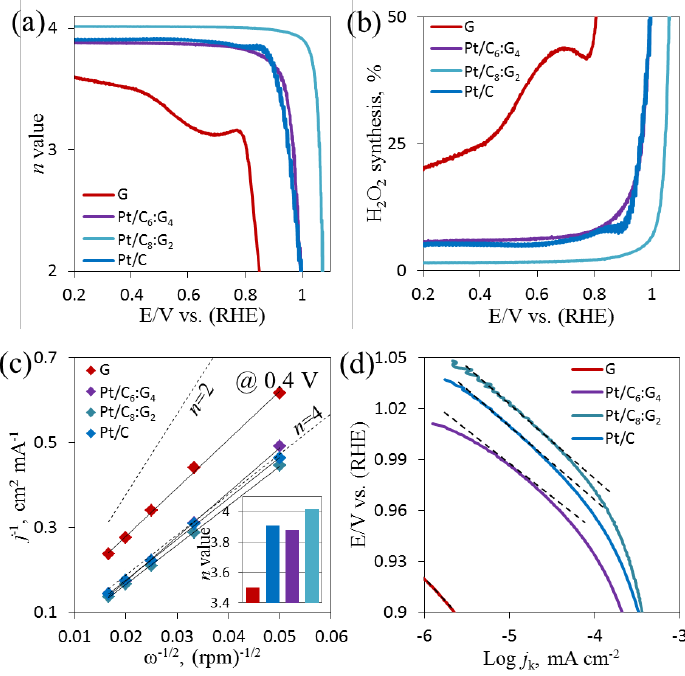
Figure 5. The calculated transferred electron number ( a ), the corresponding H 2 O 2 synthesis ( b ) during ORR in O 2 -saturated 0.1 M HClO 4 solution, the K-L plot comparison at 0.4 V (versus RHE) ( c ) and the Tafel plots ( d ) for Pt / C, Pt / C 8 :G 2 , Pt / C 6 :G 4 and G-sheets electrodes. Inset: the K-L plot derived transferred electron number at 0.4 V (versus RHE).